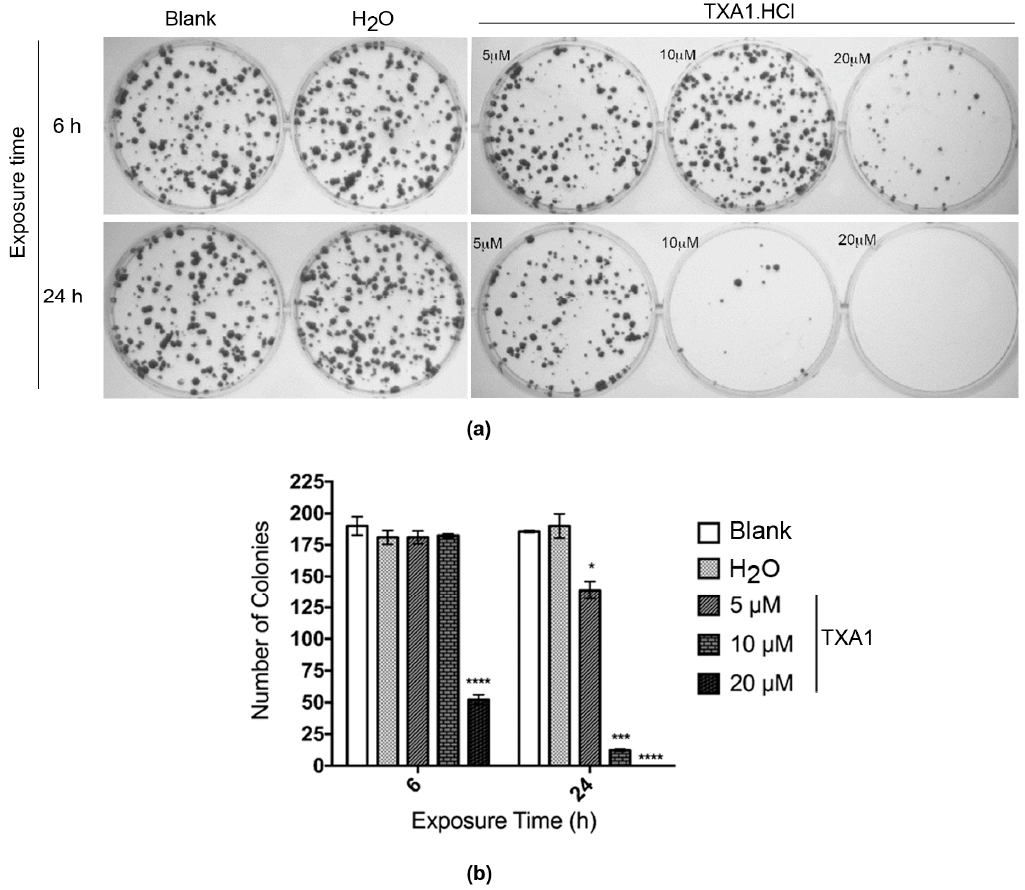
Figure 3. Effect of TXA1·HCl on the colony forming efficiency of MCF-7 cells. Cells were treated for 6 or 24 h with 5, 10 and 20 µM TXA1·HCl . Results were analyzed 14 days after recovery of the cells previously treated with TXA1·HCl . Representative images ( a ) and analysis of the number of colonies ( b ). Results are expressed as mean ± SEM, from three independent experiments. * p ≤ 0.05; *** p ≤ 0.001; **** p ≤ 0.0001 when comparing treatment vs. control ( H 2 O).